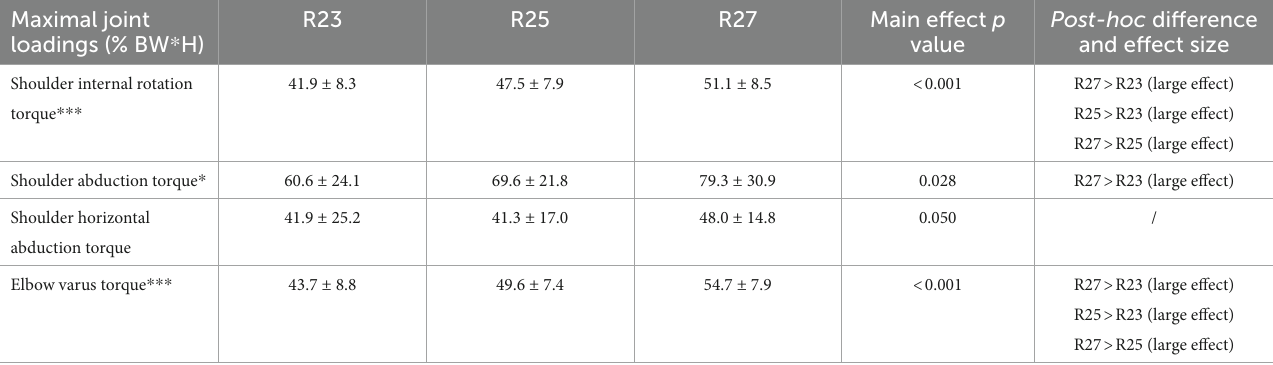
TABLE 3 Maximal joint loadings for the different racket conditions (mean ± SD). Maximal joint loadings (% BW *